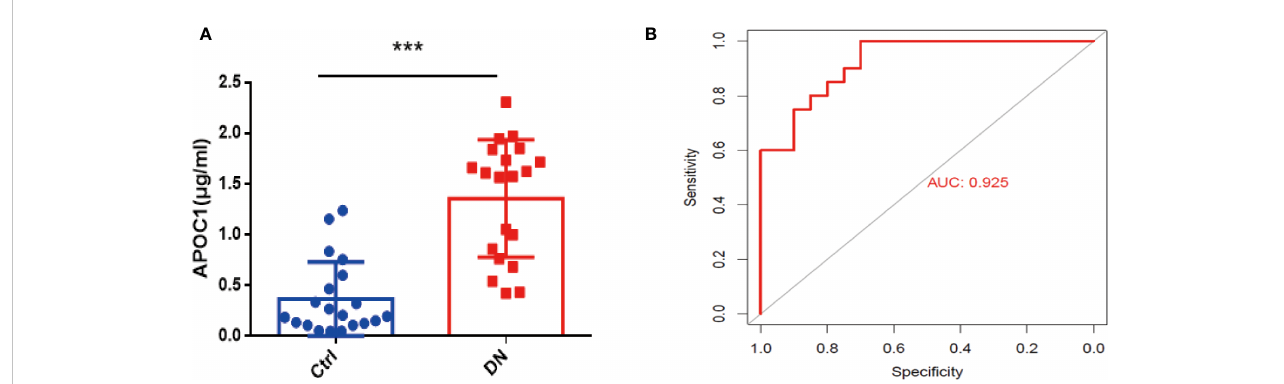
FIGURE 8 Serum APOC1 expression in DN patients and ROC. (A) APOC1 expression in serum (Ctrl n = 20, DN n = 20). (B) ROC curve of serum APOC1 expression in DN (AUC = 92.5%, sensitivity = 95%, and speci fi city = 97%, P < 0.001). Ctrl, Healthy population; DN, Diabetic nephropathy patients. ***P <